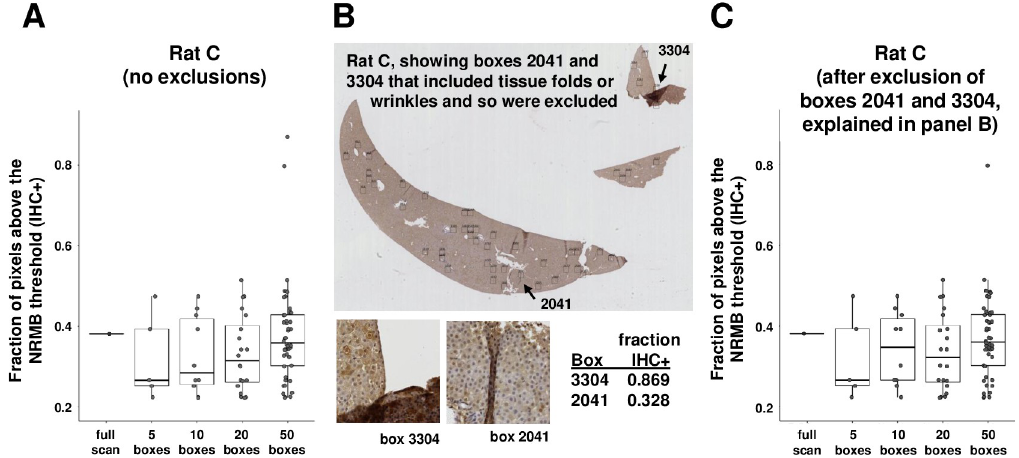
Fig 5. Excluding problem areas of slides. Sampling boxes allow the user to exclude and replace regions of slides deemed compromised, for example, by wrinkles or folds in the tissue. In this slide, there were only minimal problem areas visible (panel B) so the fraction of DAB-stained pixels estimated using random sampling boxes without exclusions (panel A) is similar to that estimated with exclusions (panel C). The impact could be larger for a more compromised